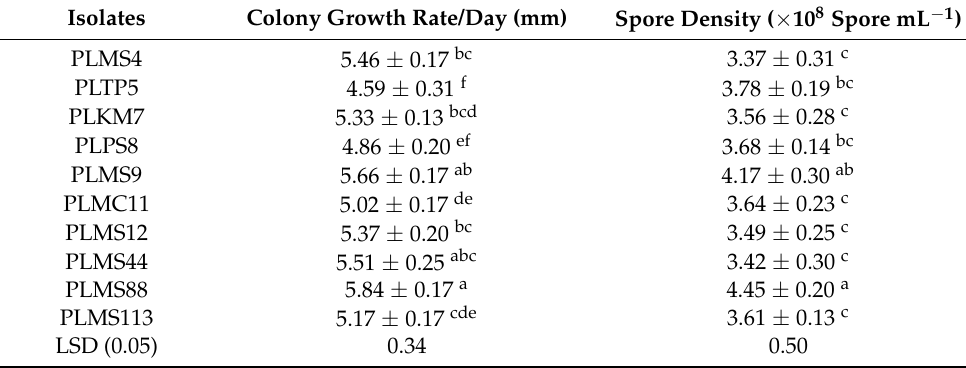
Table 2. Colony growth rate and conidia density among the proteolytic isolates.